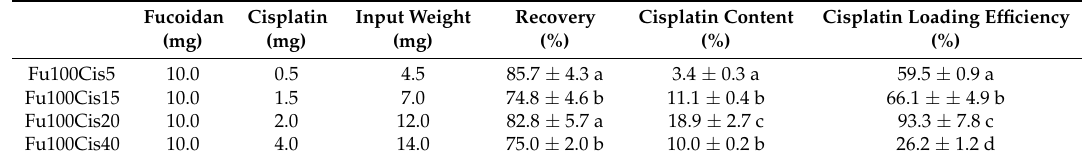
Table 2. Recovery, cisplatin content and cisplatin loading efficiency of fucoidan-cisplatin nanoparticles by 10 mg fucoidan mixing with different weights of